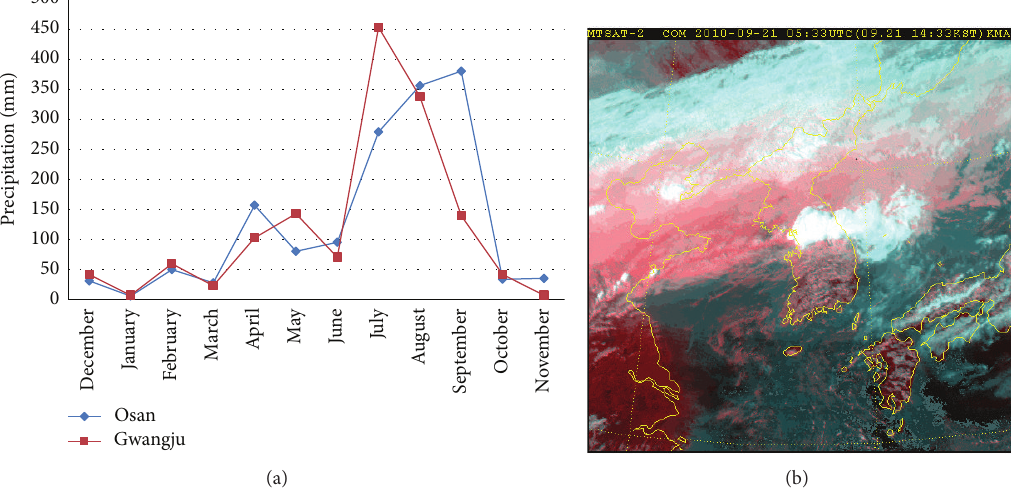
Figure 13: (a) Monthly mean precipitation observed at Osan and Gwangju during June 2010–May 2011 with re-arranged months for the 𝑥 -axis label, and (b) the composite satellite image valid at 1433LST 21 September, 2010.